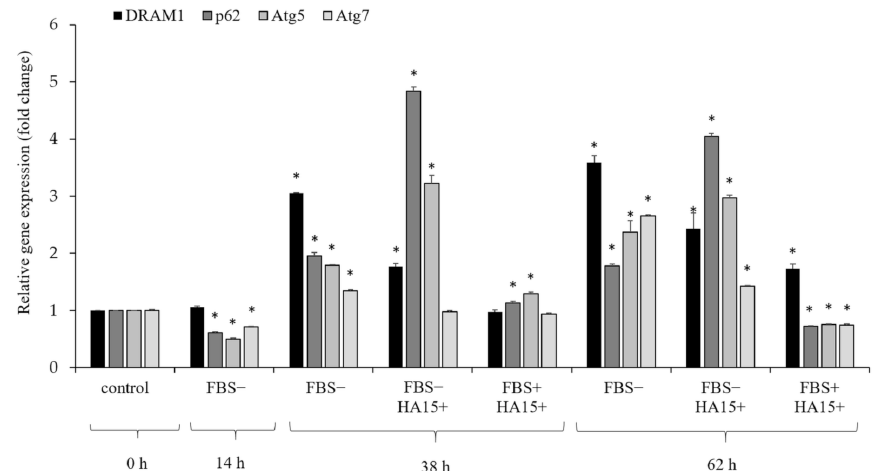
Figure 9. Relative gene expression patterns of autophagy markers in A375 cells. Cells were starved for 14 h and then incubated without FBS (FBS − ), without FBS and with 10 µ M of HA15 (FBS − HA15+), or with FBS and with 10 µ M of HA15 (FBS+HA15+) for an additional 48 h. Gene expression was measured at the indicated time points. Significant differences are indicated by asterisks (* p ≤